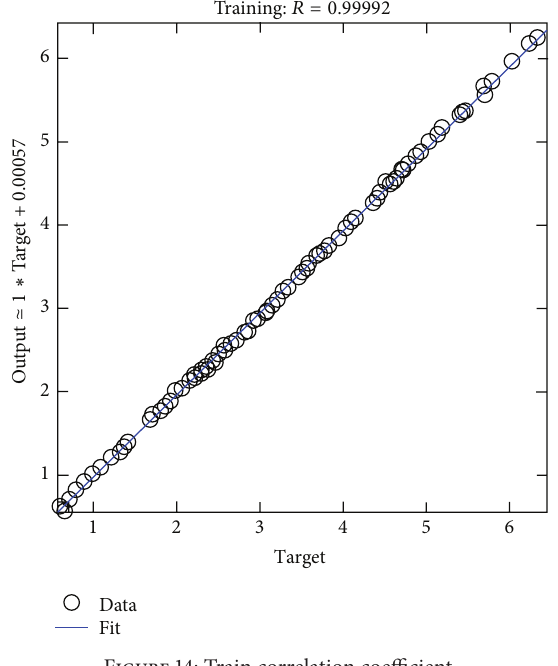
Figure 14: Train correlation coefficient.